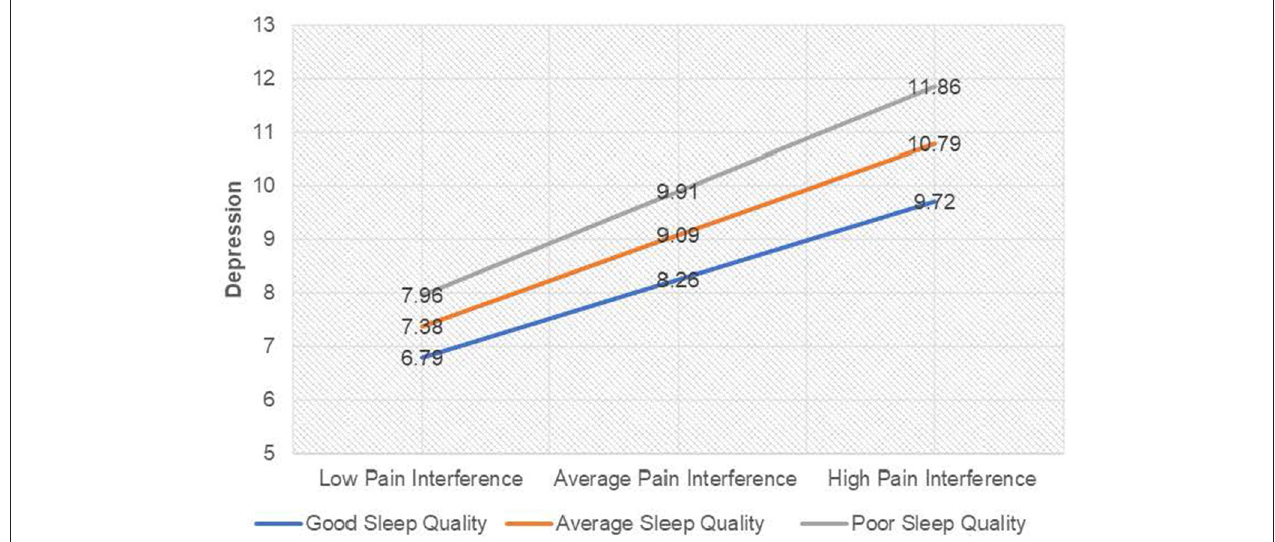
FIGURE 2 | Interaction plot for depression among individuals with chronic pain. For ease of interpretation, sleep quality labels have been raised. “Good sleep quality” as labeled on the graph denotes a score ISD below the mean on the PSQI (lower scores on the PSQI indicate better sleep quality), and “Poor sleep quality” denotes a score ISD above the mean on the PSQI (higher scores on the PSQI indicate poor sleep